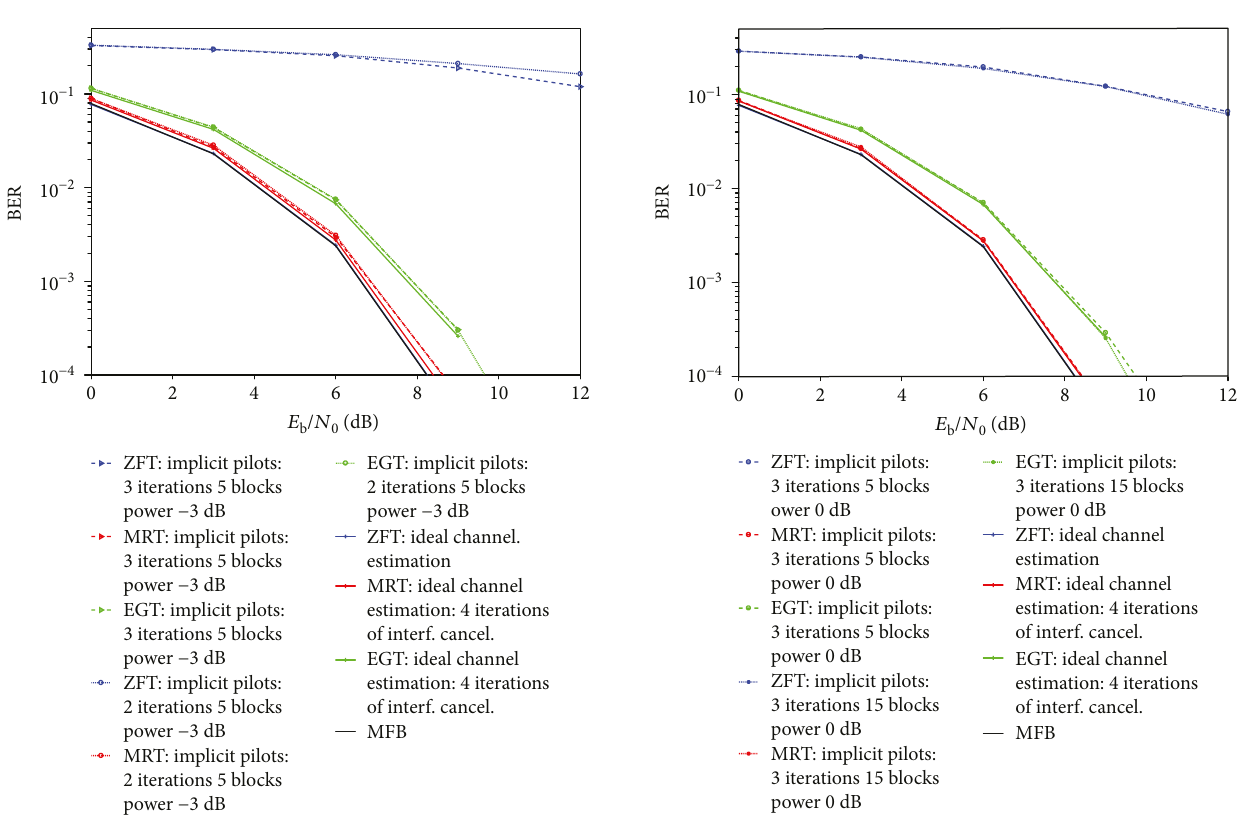
Figure 9: BER results with 32 × 2 using implicit pilots with 5 data blocks and pilot power − 3 dB, with 2 versus 3 iterations in the channel estimator.